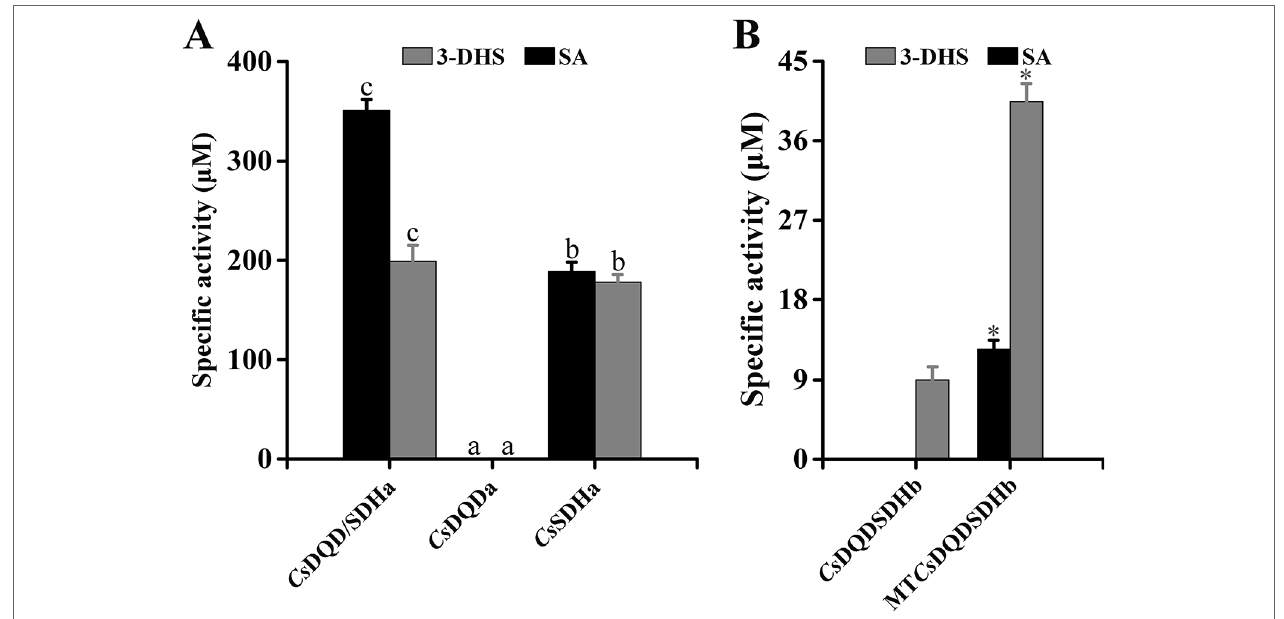
FIGURE 6 | Effect of key unit and site-directed mutagenesis on the activity of Cs DQD/SDHa and Cs DQD/SDHb, respectively. (A) Specific activity analysis of the Cs DQDa and Cs SDHa truncated mutant proteins. (B) Specific activity analysis of the purified MT Cs DQD/SDHb mutant protein. Data are presented as the means of three independent assays. Data are shown as the mean of three replicates ± SD. Different letters in (A) are statistically different at P < 0.05 according to one-way ANOVA of Duncan’s test. Asterisks in (B) indicate significant difference based on Tukey’s test ( P < 0.05). ANOVA, analysis of